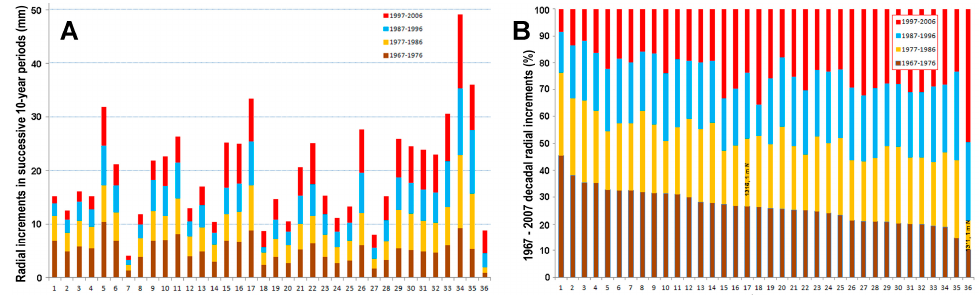
Figure 20 . Forty-year trunk increments at 1.3 m height over the 1967–2007 calendar-year period. In addition to 34 cores, data from N cardinal directions for nominal trunk height of 1 m are shown for tree 1316 (bar 17) and tree 1311 (bar 36). Tree numbers in ( A , B ) apply to the same tree. ( A ) Raw ring-width measurements of four successive decades of gišogenesis. ( B ) Data of ( A ) converted into percentage contributions made in each decade to the total 40-year increment.